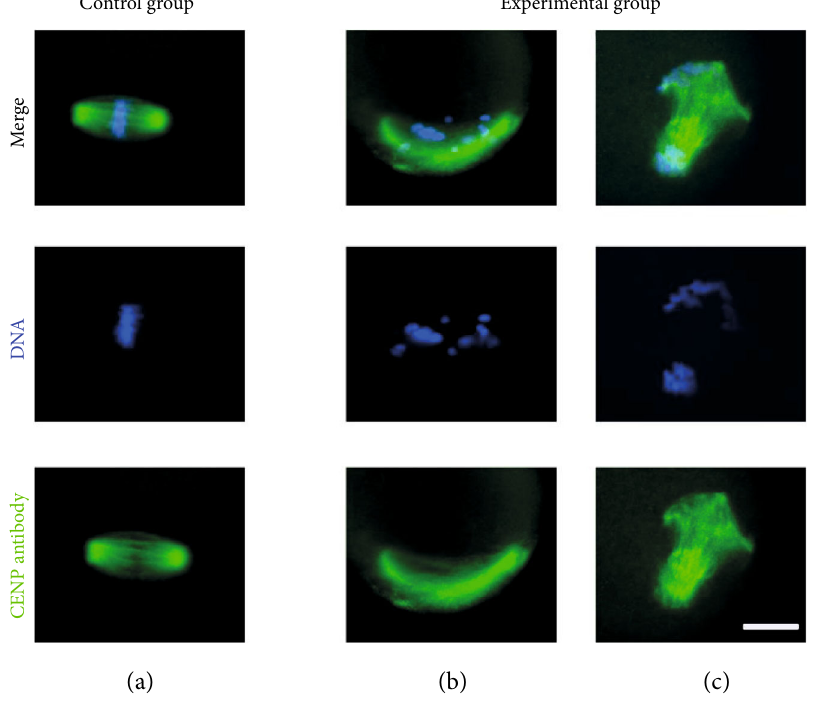
Figure 6: E ff ects of the CENP-C antibody on spindle assembly and chromosome alignment in MII oocytes. Control and experimental oocytes were stained with the tubulin antibody to visualize spindles (green) and counterstained with DAPI to visualize chromosomes (blue). Control oocytes present a bipolar barrel-shaped spindle and well-aligned chromosomes on the metaphase equator (a), whereas spindle defects and chromosome misalignment were observed in experimental oocytes (b, c). Images were captured using a 40x objective lens and 10x eyepiece. Scale bar: 20 μ